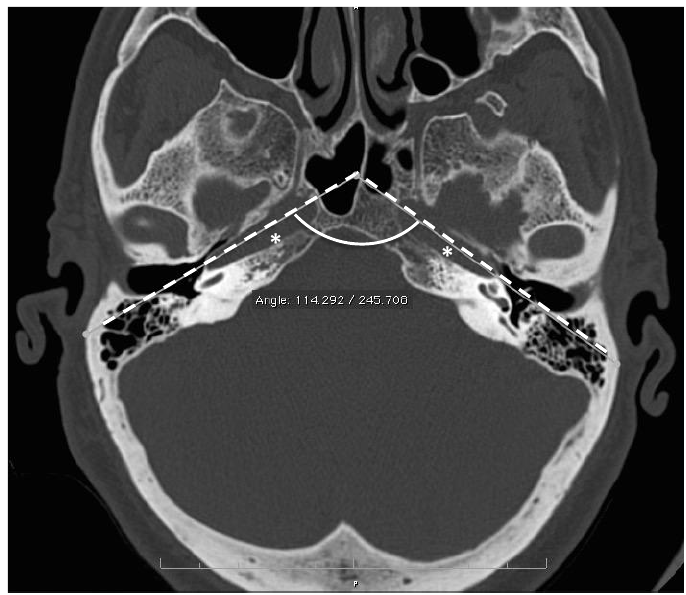
Figure 5. Measurement of the interpetrous angle in the transverse plane. The measured angle opens towards the back (formed by 2 lines passing through the center of the internal carotid artery with the vomer axis as the apex). *: internal carotid artery.